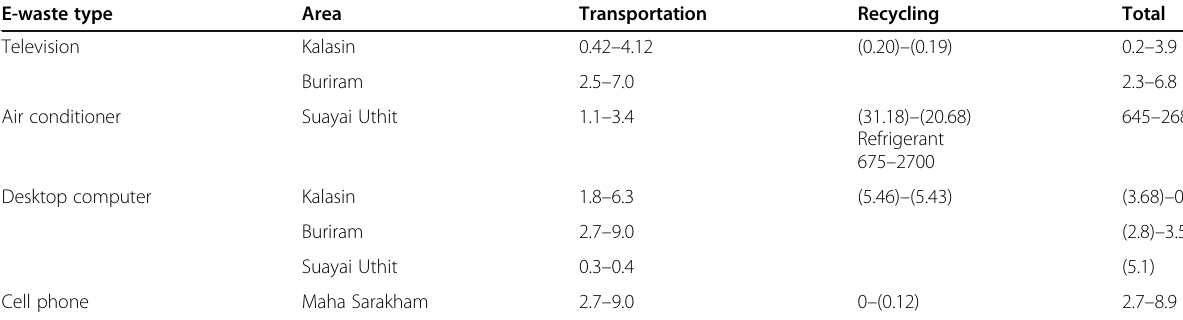
Table 4 Summary of life cycle GHG of e-waste (kg CO 2eq /unit) E-waste type